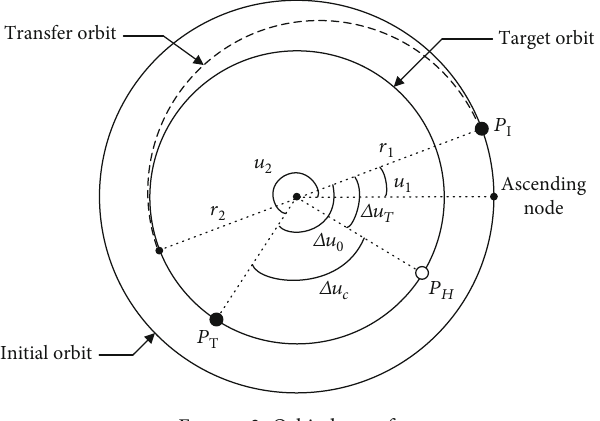
Figure 3: Orbital